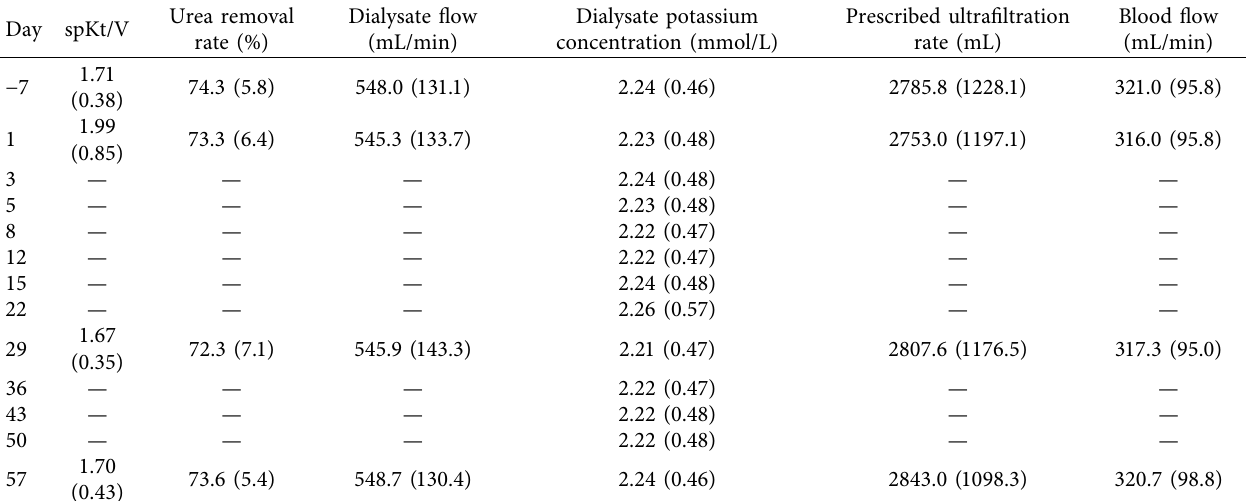
Table 3: Dialysis adequacy and prescription parameters in placebo patients ( n �